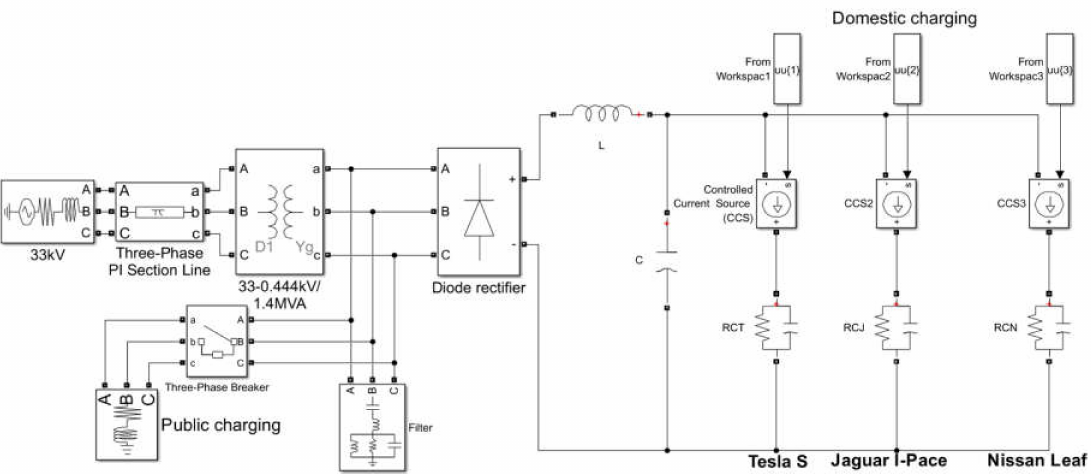
Figure 13. Grid system with public